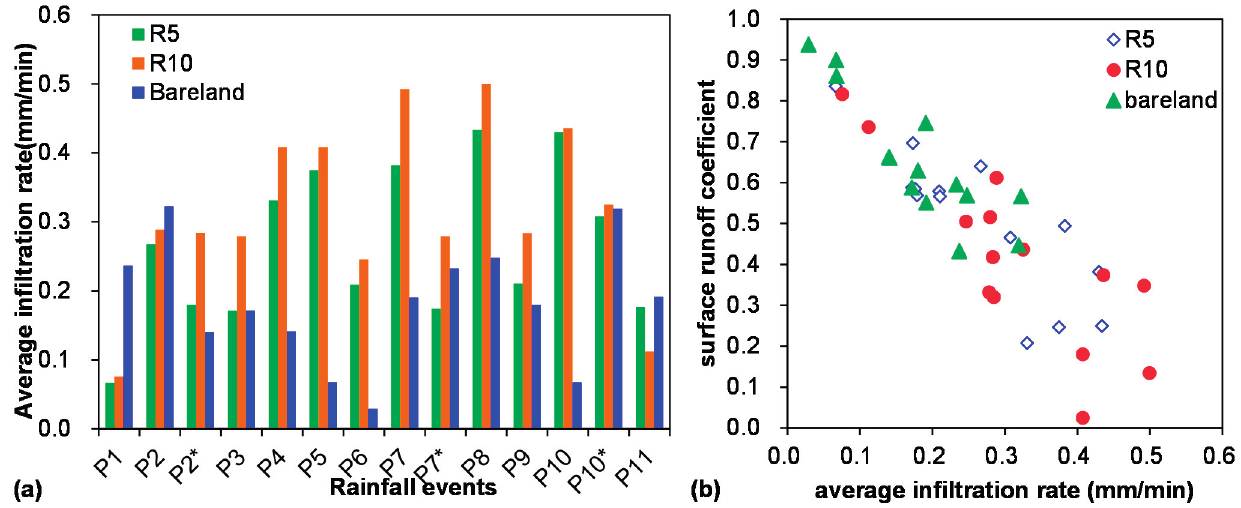
Figure 7. ( a ) Average infiltration rate in the 11 rainfall events and ( b ) the relationship between the surface runoff coefficient and the average infiltration rate.